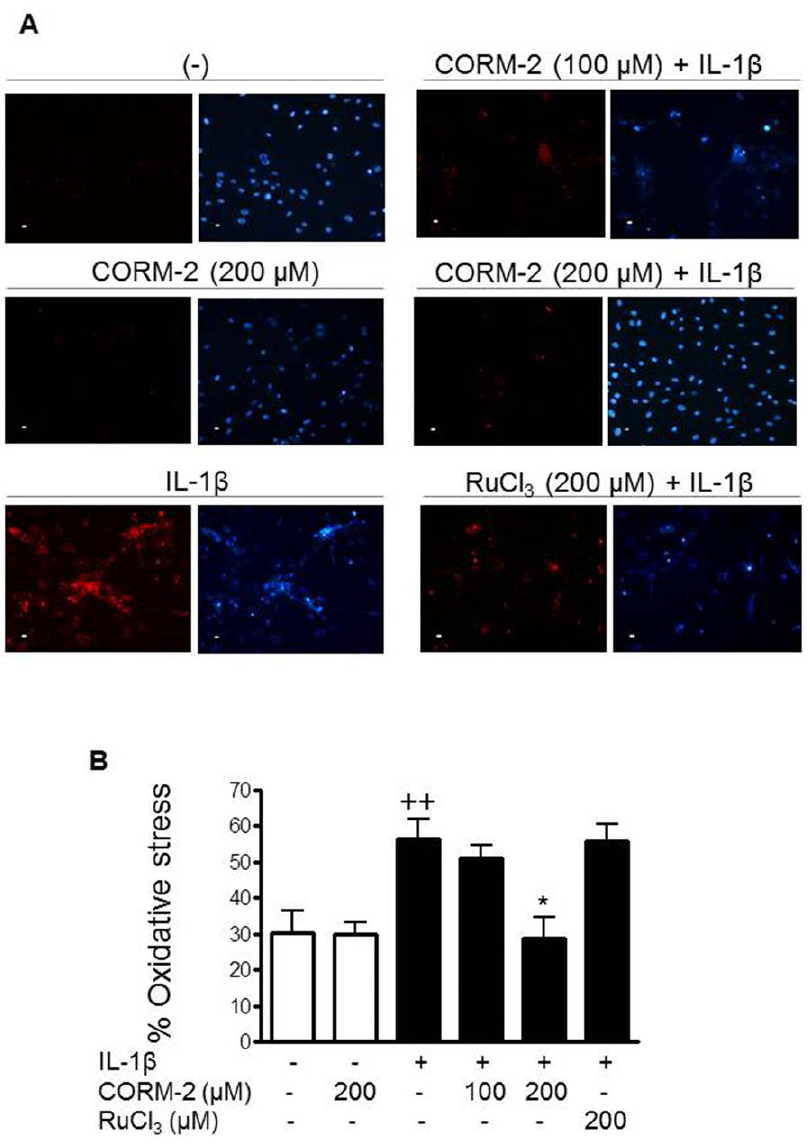
Figure 7. Effect of CORM-2 on oxidative stress levels in OA synoviocytes. Cells were incubated with IL-1 b (10 ng/ml) in the presence or absence of CORM-2 (100, 200 m M) or RuCl 3 (200 m M) for 30 min. Oxidative stress was measured by the oxidation of dihydrorhodamine 123. Rhodamine positive cells were counted in 6–8 microscopic power fields. Data are expressed as % of oxidative stress. Left panels: oxidative stress, right panels: DAPI. Duplicate samples from 3 patients were used. + P , 0.05 with respect to nonstimulated cells. * P , 0.05 with respect to IL-1 b . Original magnification: x200.